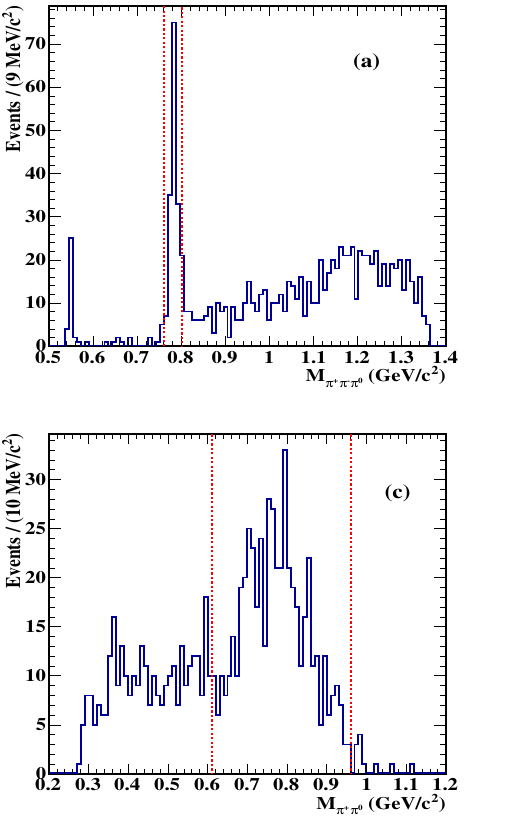
(cid:25) (cid:0) (c) (cid:25) + (cid:25) 0 and (d) K 0 (cid:25) 0 S S